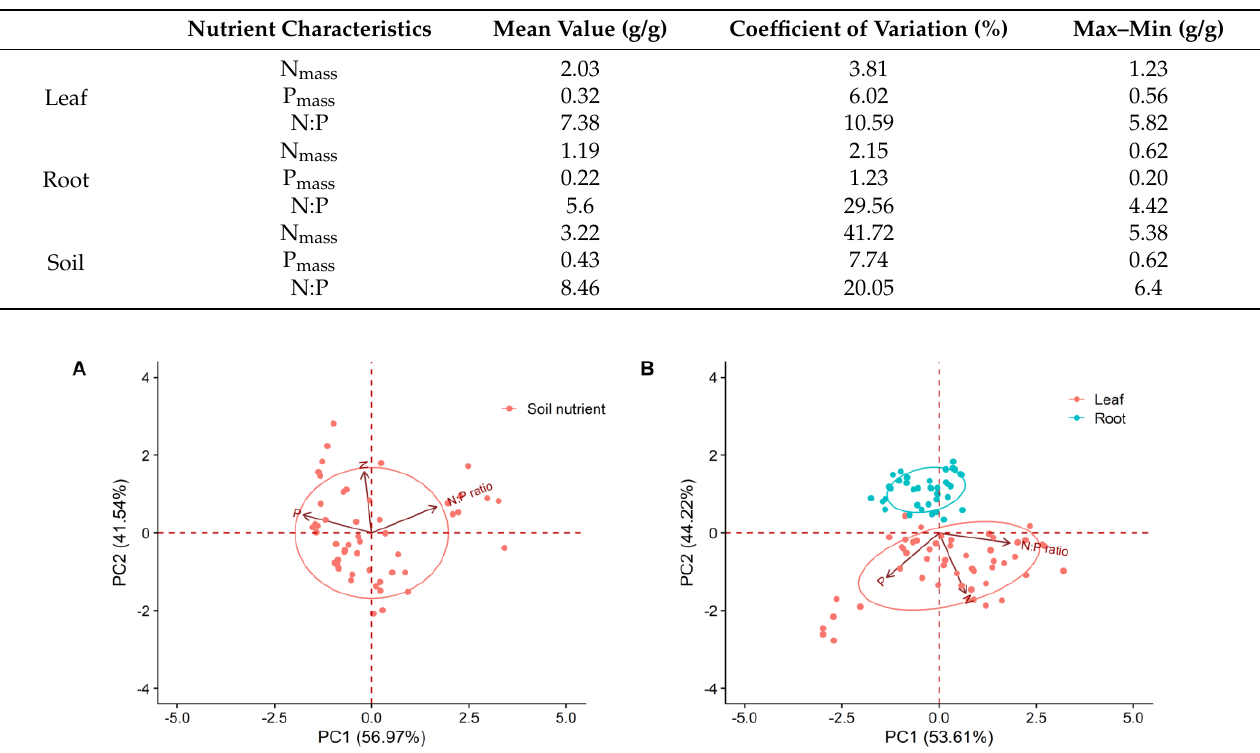
Figure 2. Principal component analysis (PCA) of nutrient characteristics of ( A ) soil and ( B ) leaves and roots. Nutrient characteristics included the N mass , P mass and N/P